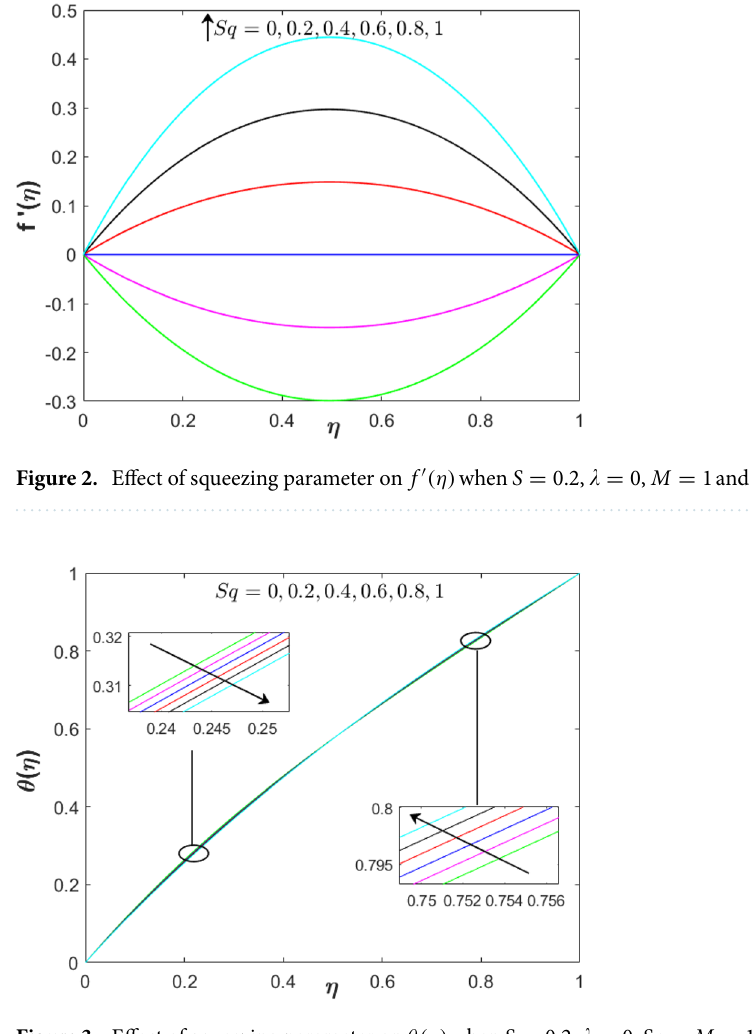
Figure 3. Effect of squeezing parameter on θ(η) when S = 0.2 , (cid:31) = 0 , Sq = M = 1 and φ 1 = φ 2 = 0.01 .